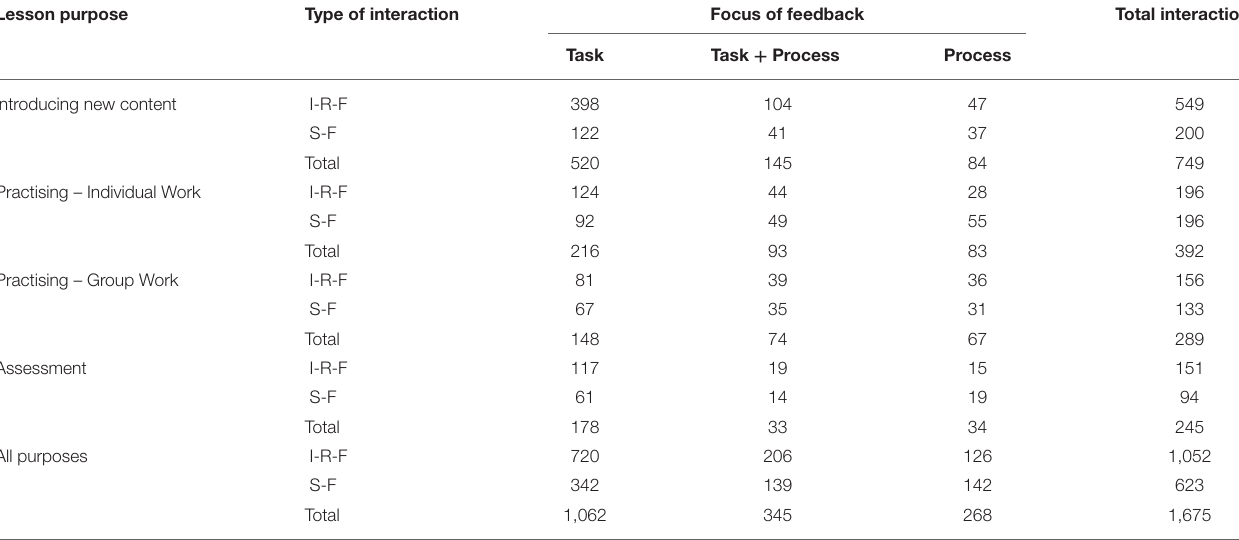
TABLE 6 | Frequency of the focus of feedback according to the lesson purpose and the type of interaction. Lesson purpose